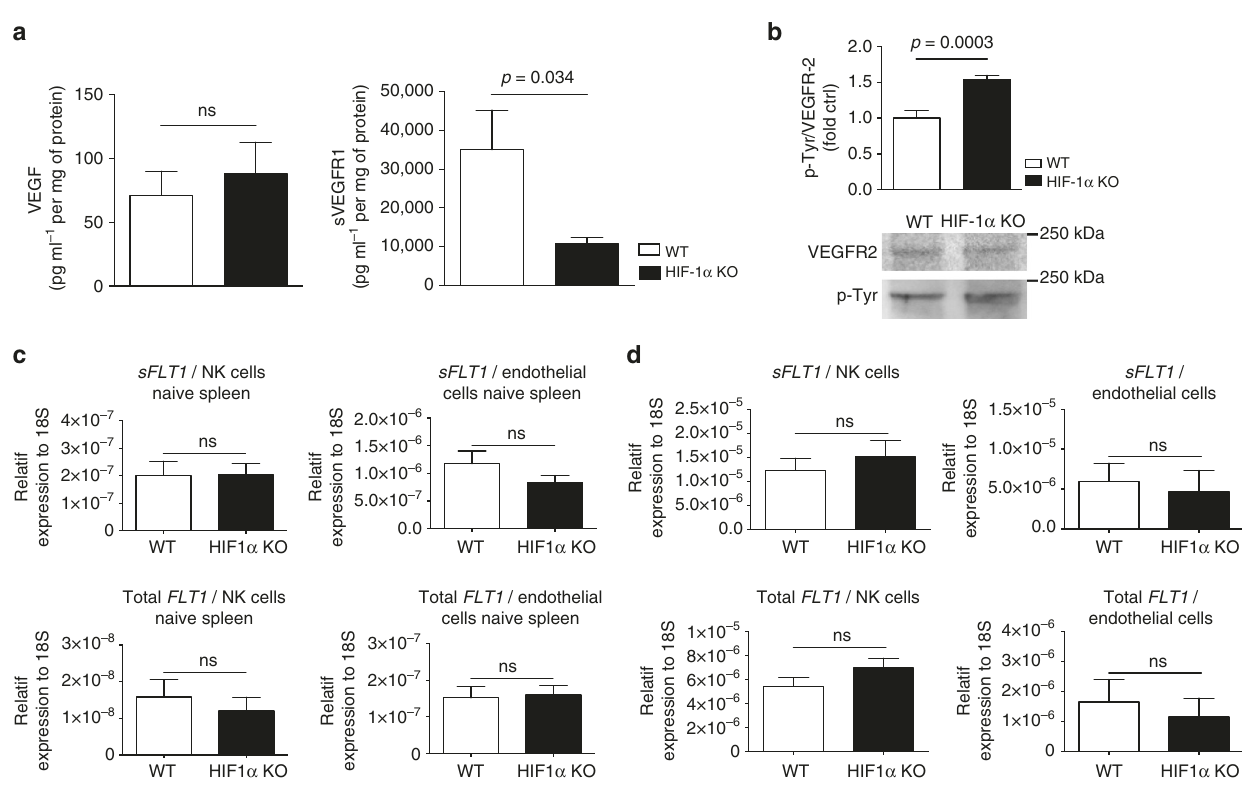
Fig. 3 NK cell HIF-1 α de fi ciency increases VEGF bioavailability and endothelial cell migration. a Determination of levels of VEGF and sVEGFR1 protein in MC38 isografts implanted in WT and HIF-1 α KO mice by ELISA at endpoint, day 14 ( n = 8). b Immunoblotting for VEGFR2 and phosphotyrosine (p-Tyr) after immunoprecipitation of VEGFR2 from MC38 tumour lysates and ratio of p-Tyr and VEGFR2 signal intensities as measured by photon emission at endpoint, day 14 ( n = 8). c Gene expression analysis for soluble variant of FLT1 and total form of FLT1 on sorted NK cells and endothelial cells from naïve spleens from WT and HIF-1 α KO mice ( n = 6). d Gene expression analysis for soluble variant of FLT1 and total form of FLT1 on sorted intratumoural NK cells and endothelial cells from MC38 tumours injected subcutaneously in WT and HIF-1 α KO mice at endpoint, day 10 ( n = 10). Statistical signi fi cance was determined by an unpaired Student ’ s t -test or one-way analysis of variance, where appropriate. Bars represent mean values; error bars indicate the s.e.m. Statistical signi fi cance is indicated as * P < 0.05, ** P < 0.01, and *** P <